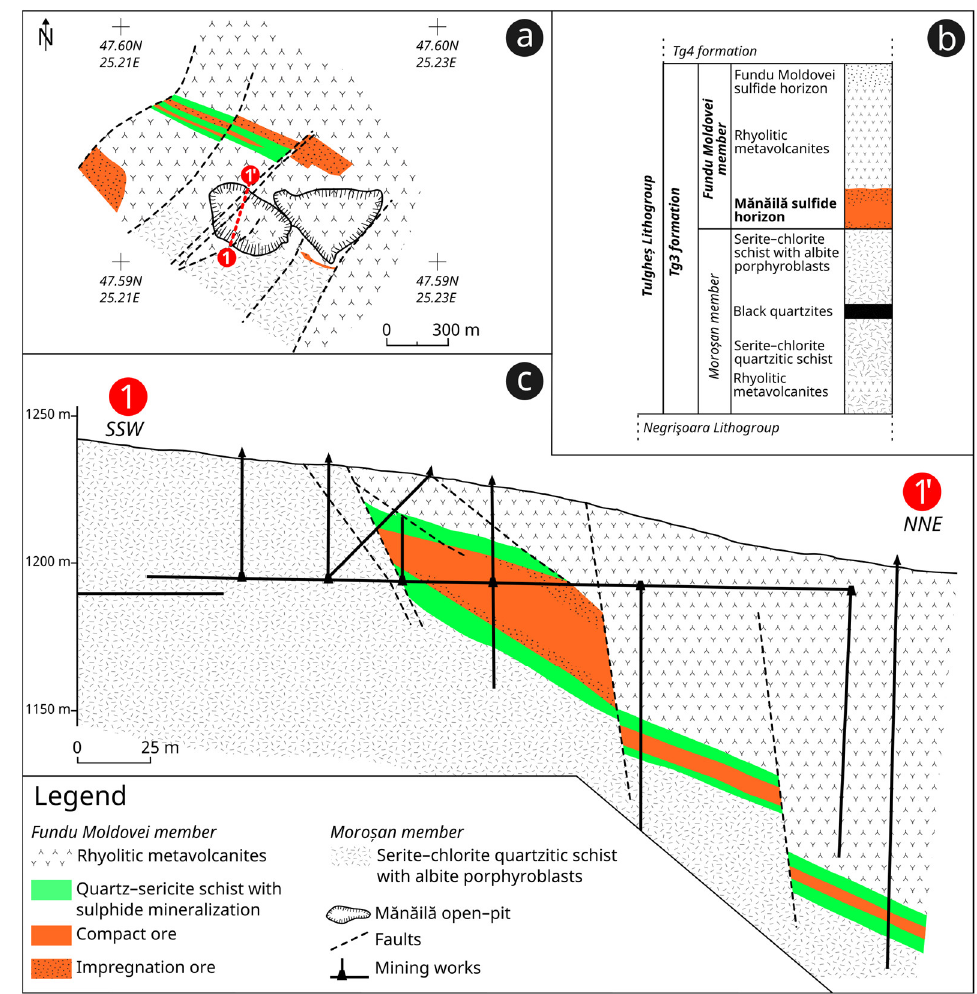
Figure 2. Simplified geological map of the Mănăilă ore deposit—modified after Harvey [21] ( a ); simplified lithostratigraphic sequence—modified after [10] ( b ); geological cross-section through the Mănăilă ore deposit ( c ).